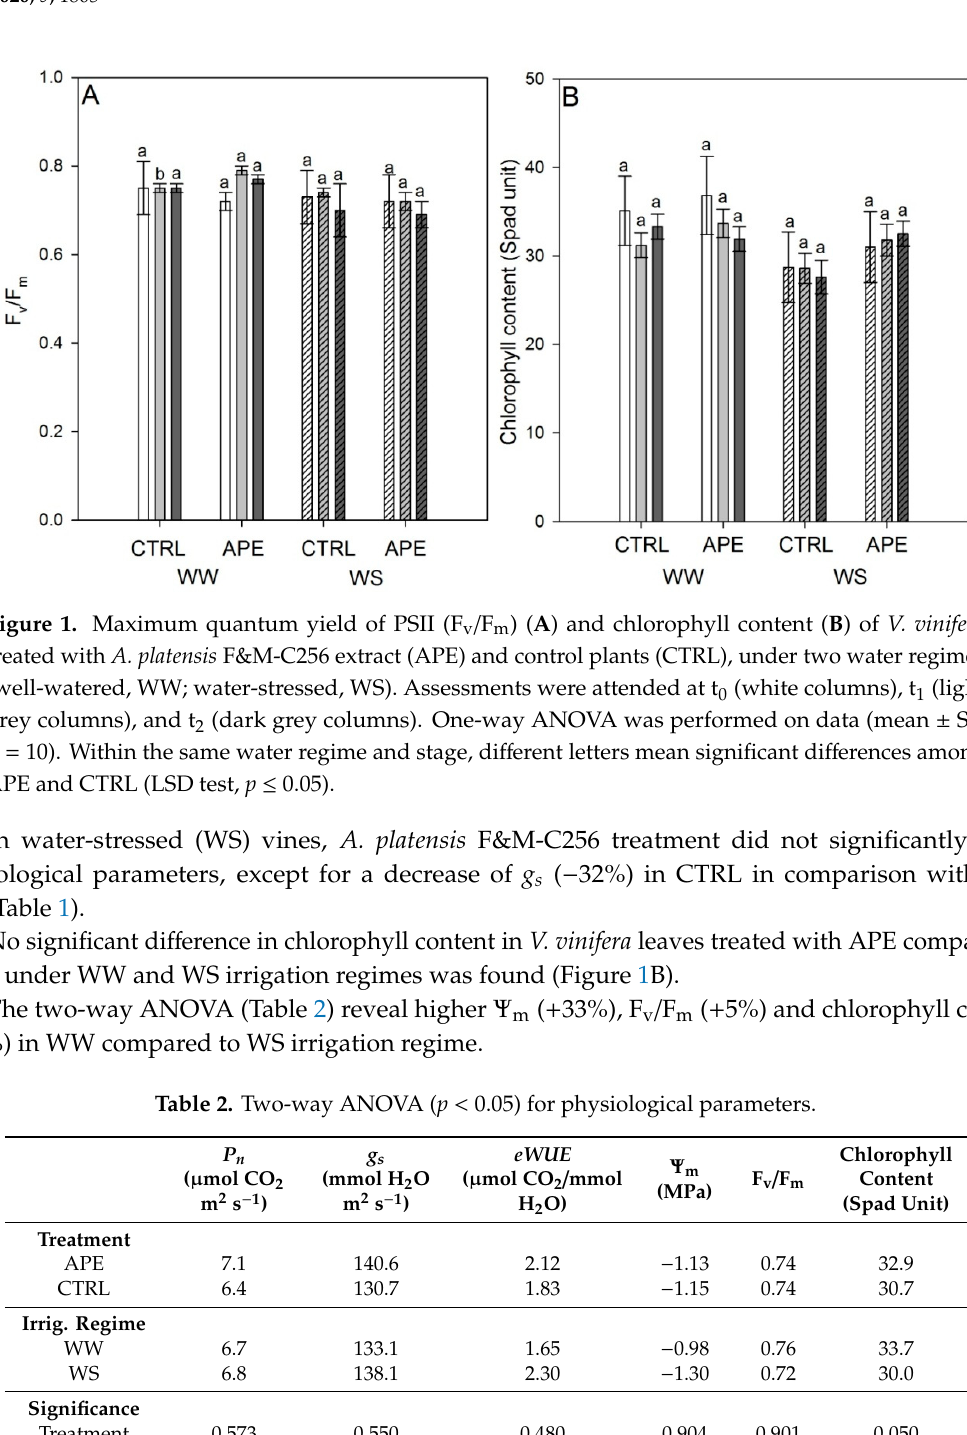
Table 2. Two-way ANOVA ( p < 0.05) for physiological parameters.